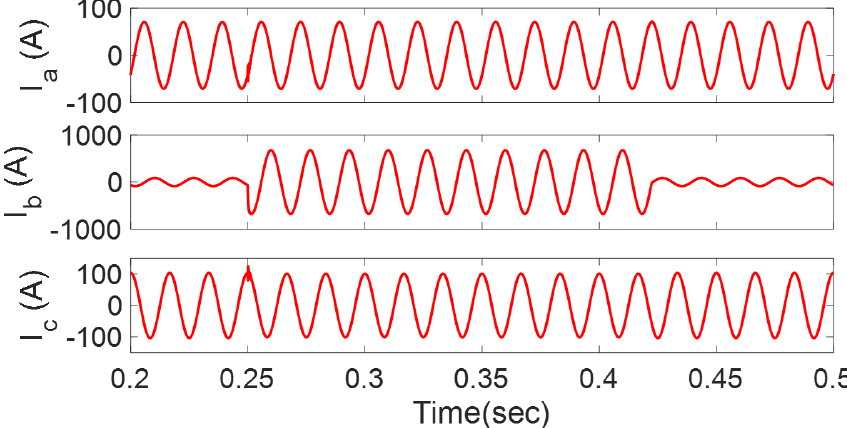
Figure 4. Per phase fault current levels between zone 1 and zone 2 (sensor